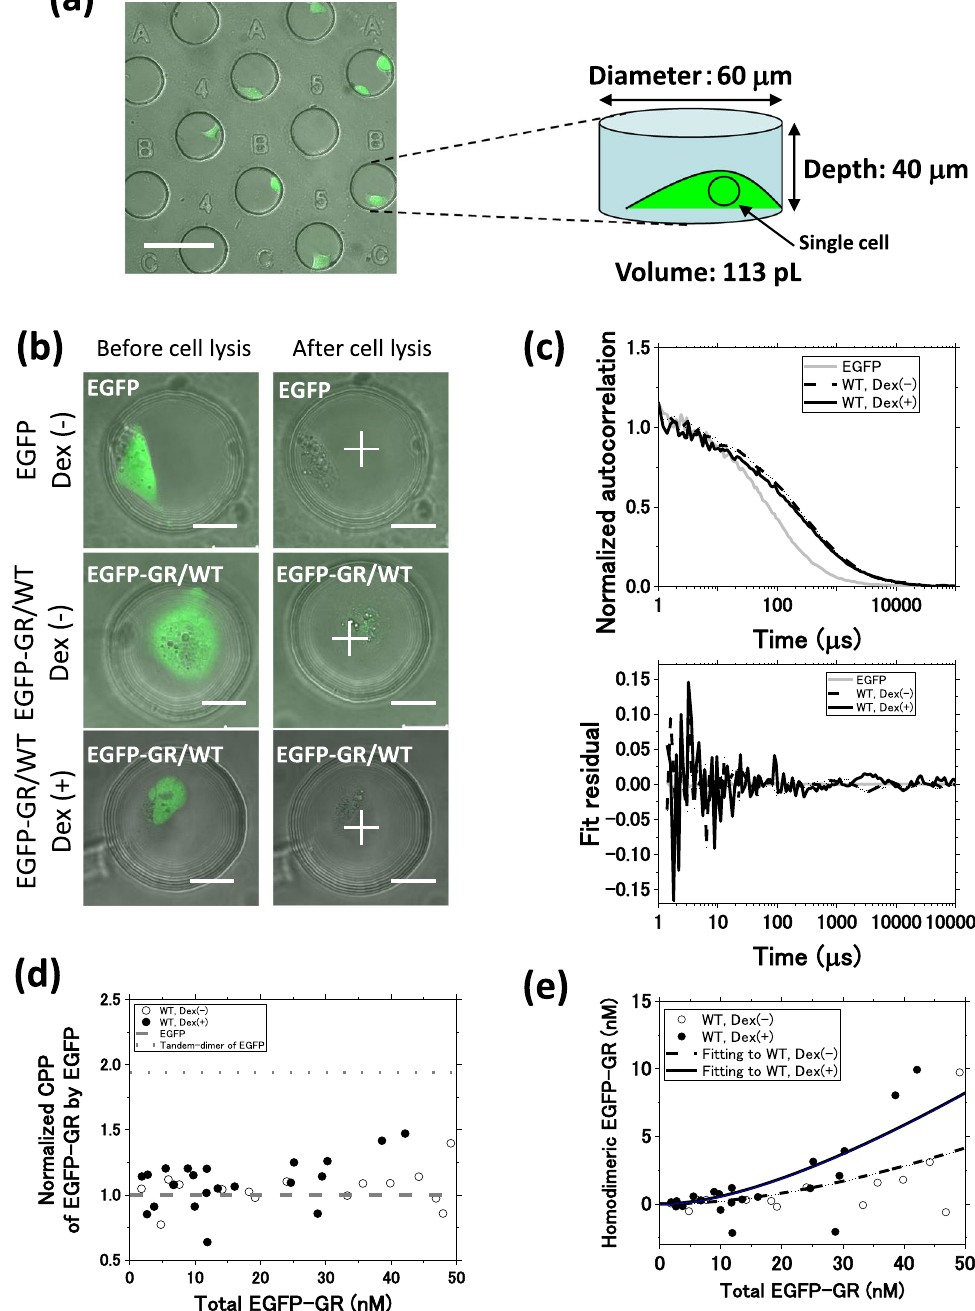
Figure 1. Homodimerization of wild-type glucocorticoid receptor assessed by an FCS-microwell system. ( a ) A fluorescent image of a single cell cultured in a microwell (diameter: 60 μ m, depth: 40 μ m, volume: 113 pL) on a polydimethylsiloxane (PDMS) chip. ( b ) A fluorescent image of a single cell expressing EGFP or EGFP-GR/ WT, in the absence and presence of Dex, before and after cell lysis. White crosses indicate the position of FCS measurements. Scale bar: 20 μ m. ( c ) Typical normalized autocorrelation functions and fit residuals for EGFP and EGFP-GR/WT in the absence and presence of Dex. Grey solid line: EGFP; black dashed line: EGFP-GR/WT in the absence of Dex; black solid line: EGFP-GR/WT in the presence of Dex. ( d ) Normalized CPP of EGFP-GR/ WT in the 0–50 nM concentration range. The full concentration range is shown in Fig. S6A. Black open circle: GR/ WT in the absence of Dex, black filled circle: GR/WT in the presence of Dex, grey dashed line: EGFP. ( e ) K d,homo determination by non-linear least squares fitting of equation (16) (Supplemental Methods) in the 0–50 nM range. Black open circle: GR/WT in the absence of Dex (N = 21), black filled circle: GR/WT in the presence of Dex (N = 15), black dashed and solid lines: Fitting curve for GR/WT in the absence of Dex ( K d,homo : 420 ± 120 nM, ± 40 nM, Χ 2 = 3.2). The K ± SE. The full Χ 2 = 4.9) and under Dex treatment ( K d,homo : 140 d,homo values are averages concentration range is shown in Fig. S6B. Χ 2 represents the chi-square value per degree of